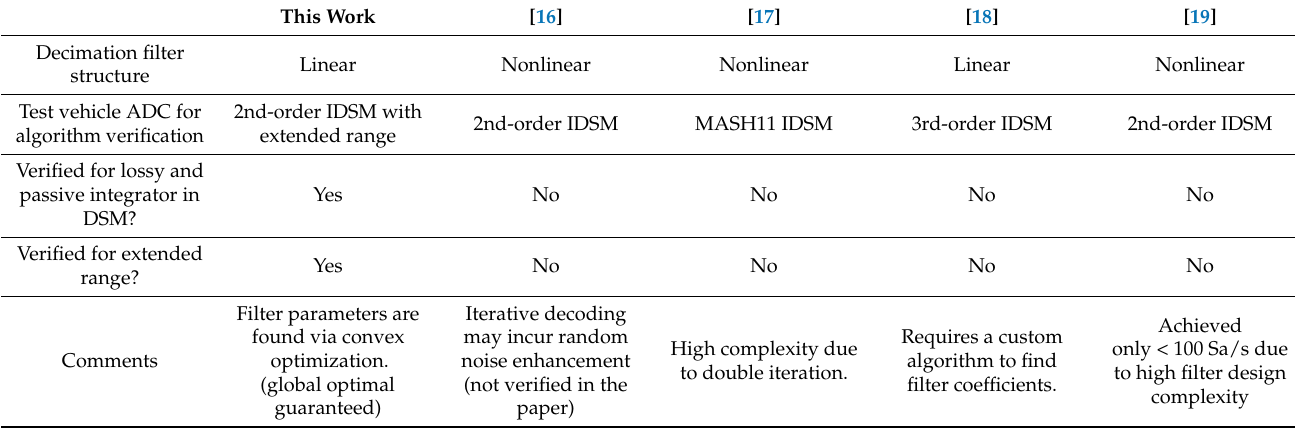
Table 2. Comparison of various digital filter techniques for incremental delta-sigma modulator (IDSM).